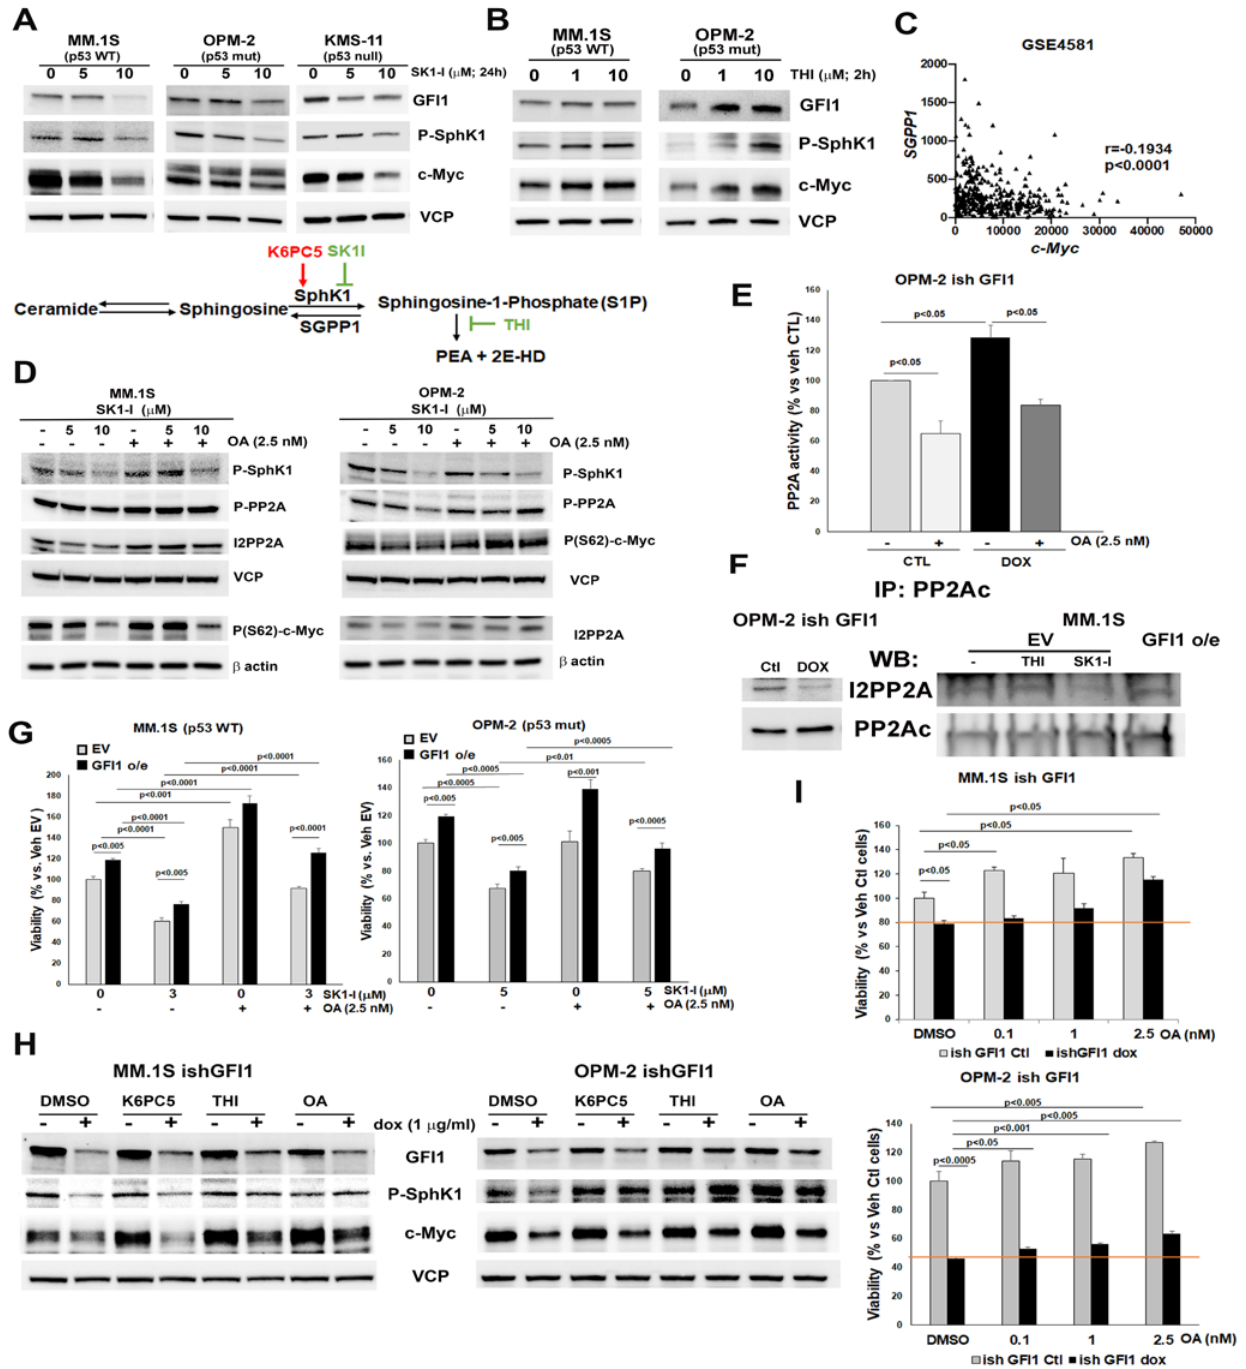
Figure 6. Intracellular S1P levels modulate c-Myc protein stability in a protein phosphatase 2A (PP2A)-dependent manner. Cell lysates were analyzed by WB (original data in Figure S6) using specific antibodies as indicated and representative immunoblots are shown ( A , B , D , F , H ). Immunoblots are arranged with the internal control used for the same samples and, therefore, are not in the same order for the different cell lines in ( D ). DMSO is the vehicle control (also shown as 0) for all treatments. MM.1S ishGFI1 and OPM-2 ishGFI1 were treated or not with dox (1 μg/mL, 3 days) to induce GFI1 KD (E, F, H-I). MM.1S, OPM-2 and KMS-11 cells were treated with SK1-I for 24 h. A schematic of S1P synthesis and degradation (main enzymes and their specific inhibitors) is shown below ( A ); MM.1S and OPM-2 cells were treated with THI (0, 1, 10 µ M, 24 h) ( B ); Spearman correlations (r= − 0.1934) between c-Myc and SGPP1 mRNAs ( p < 0.0001 by two-tailed test) in MM patient samples (n = 414)